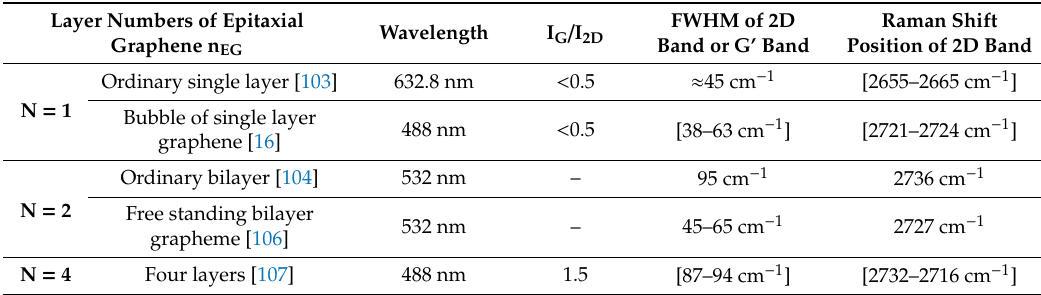
Table 1. Intensity ratio (I G / I 2D ), full width at half maximum (FWHM) of the 2D mode and Raman frequency of the 2D mode of various layer number of epitaxial graphene n EG